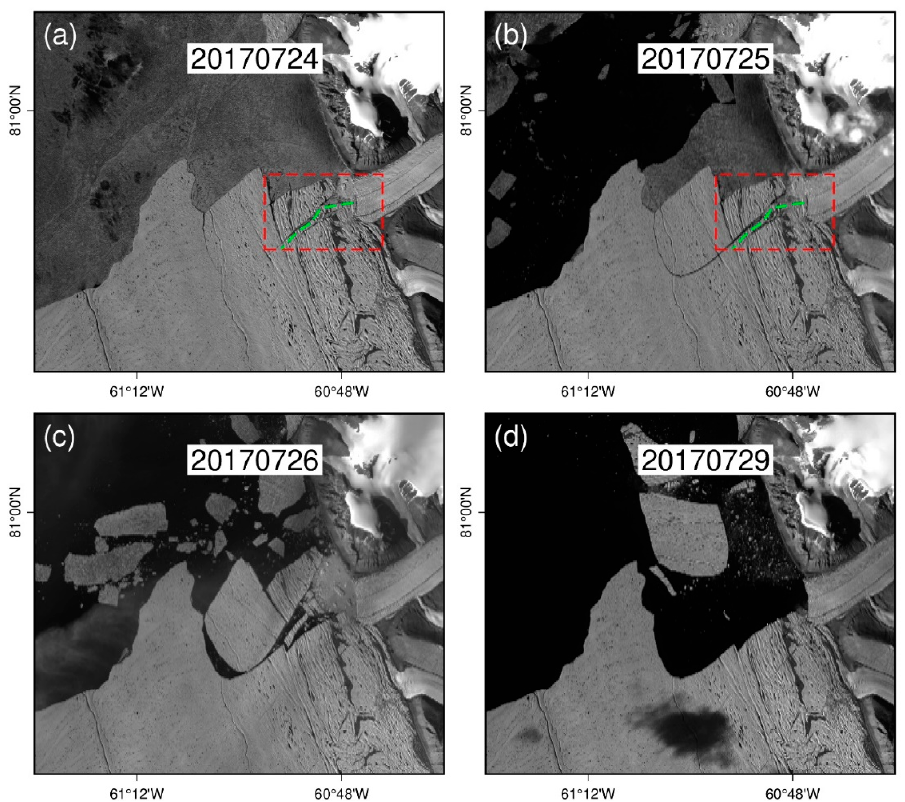
Figure 2. The sequence of Sentinel-2 NIR-band images showing the Petermann Glacier terminus collapse event in 2017. ( a ) The fracture of the terminus region occurring; ( b ) the fracture of the terminus region widening; ( c ) the frontal collapse event that occurred on 26 July 2017; ( d ) iceberg drift after collapse. The red polygon region shows the shear zone and the green line denotes the bending deformed ice.